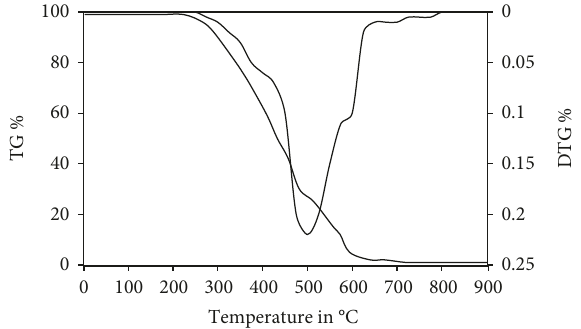
Figure 2: TG and DTG analyses of waste PET polymer.